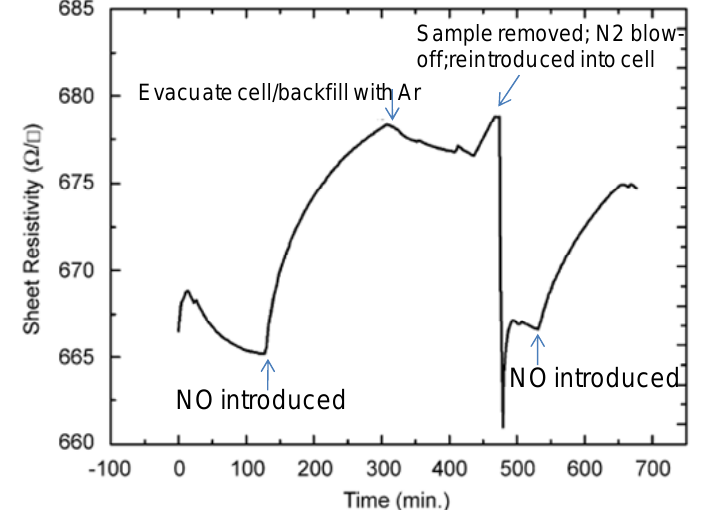
Figure 10. Sheet resistivity of the hemin functionalized GaN HFET as a function of NO exposure.